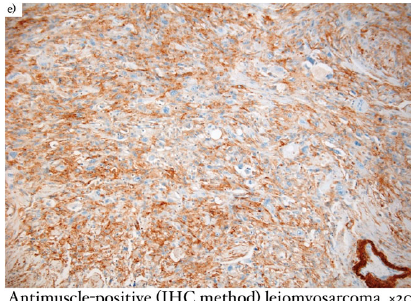
Figure 1. ( a ) Microscopical aspect of leiomyosarcoma of the breast (coloration Hematoxylin/Eosin), ×20; ( b ) Anti-desmin positive (IHC method) leiomyosarcoma, ×10; ( c ) Caldesmon–positive (IHC method) leiomyosarcoma, ×10; ( d ) SMA–positive (IHC method) leiomyosarcoma, ×20; ( e ) anti-muscle–positive (IHC method) leiomyosarcoma, ×20.